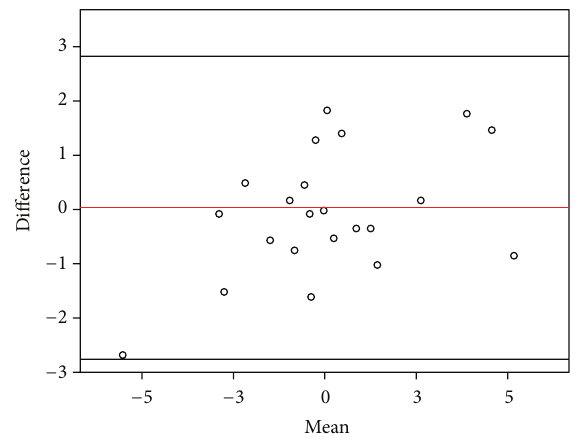
Figure 4: Bland-Altman plot of two observer’s agreement of component alignment for five different bones. Red line = mean difference, Black lines = ± 1.96